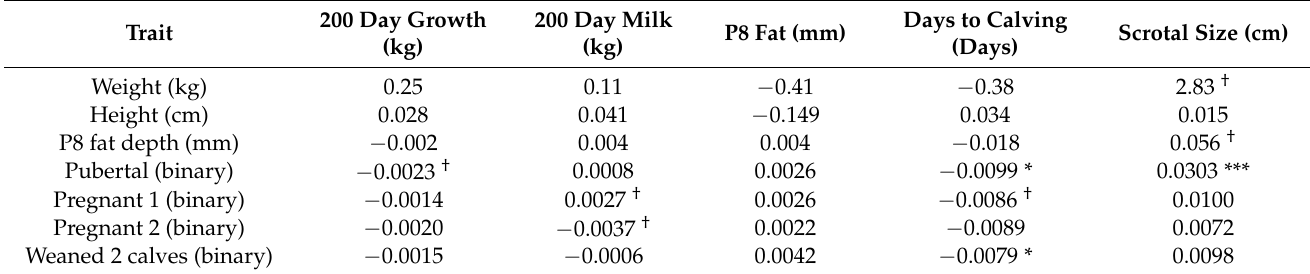
Table 4. Regression of sire GEBVs on BREEDPLAN